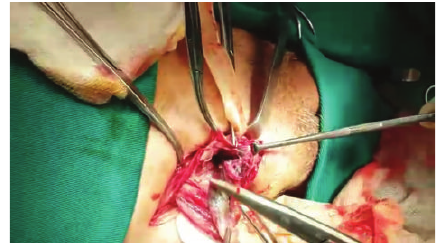
Figure 2: Hernia sac in the right inguinal region.